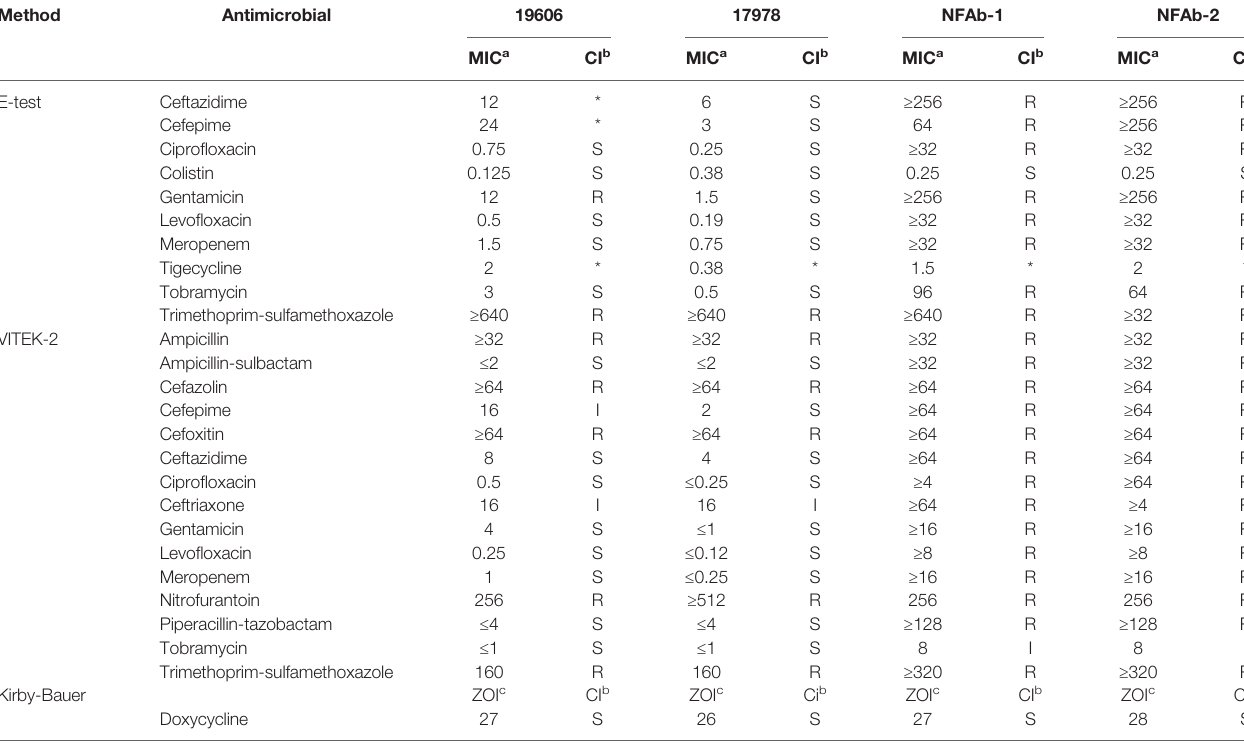
TABLE 2 | Antimicrobial susceptibilities of A. baumannii isolates.